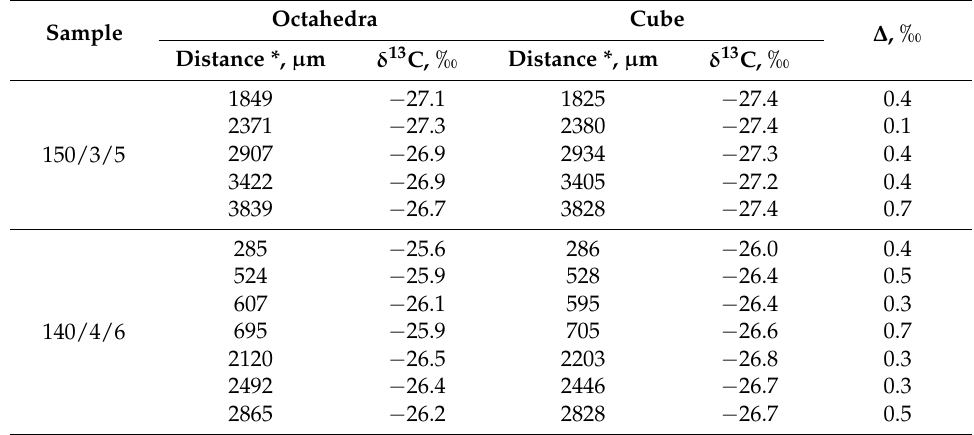
Table 3. SIMS data of δ 13 C values measured in adjusted sectors of faces of octahedra and cube in synthetic diamond crystals from Fe-Ni-C system. See [5] for details.